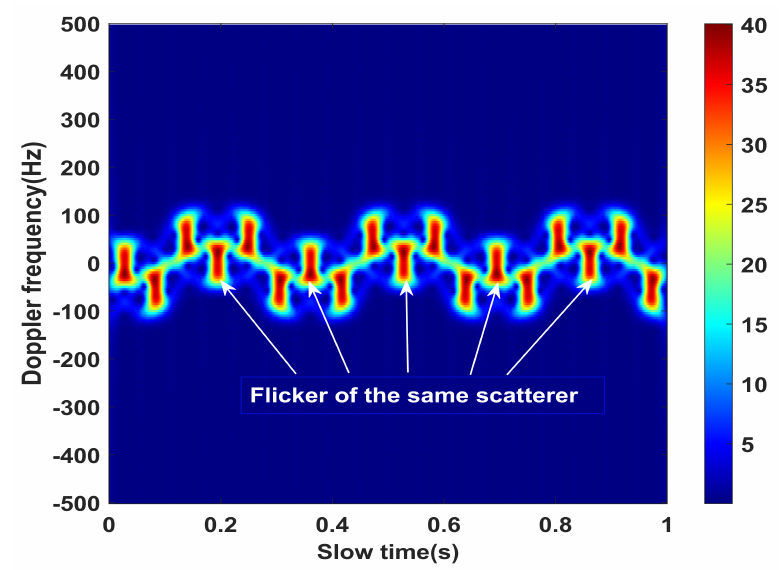
Figure 8. The best results obtained by the fourth iteration.